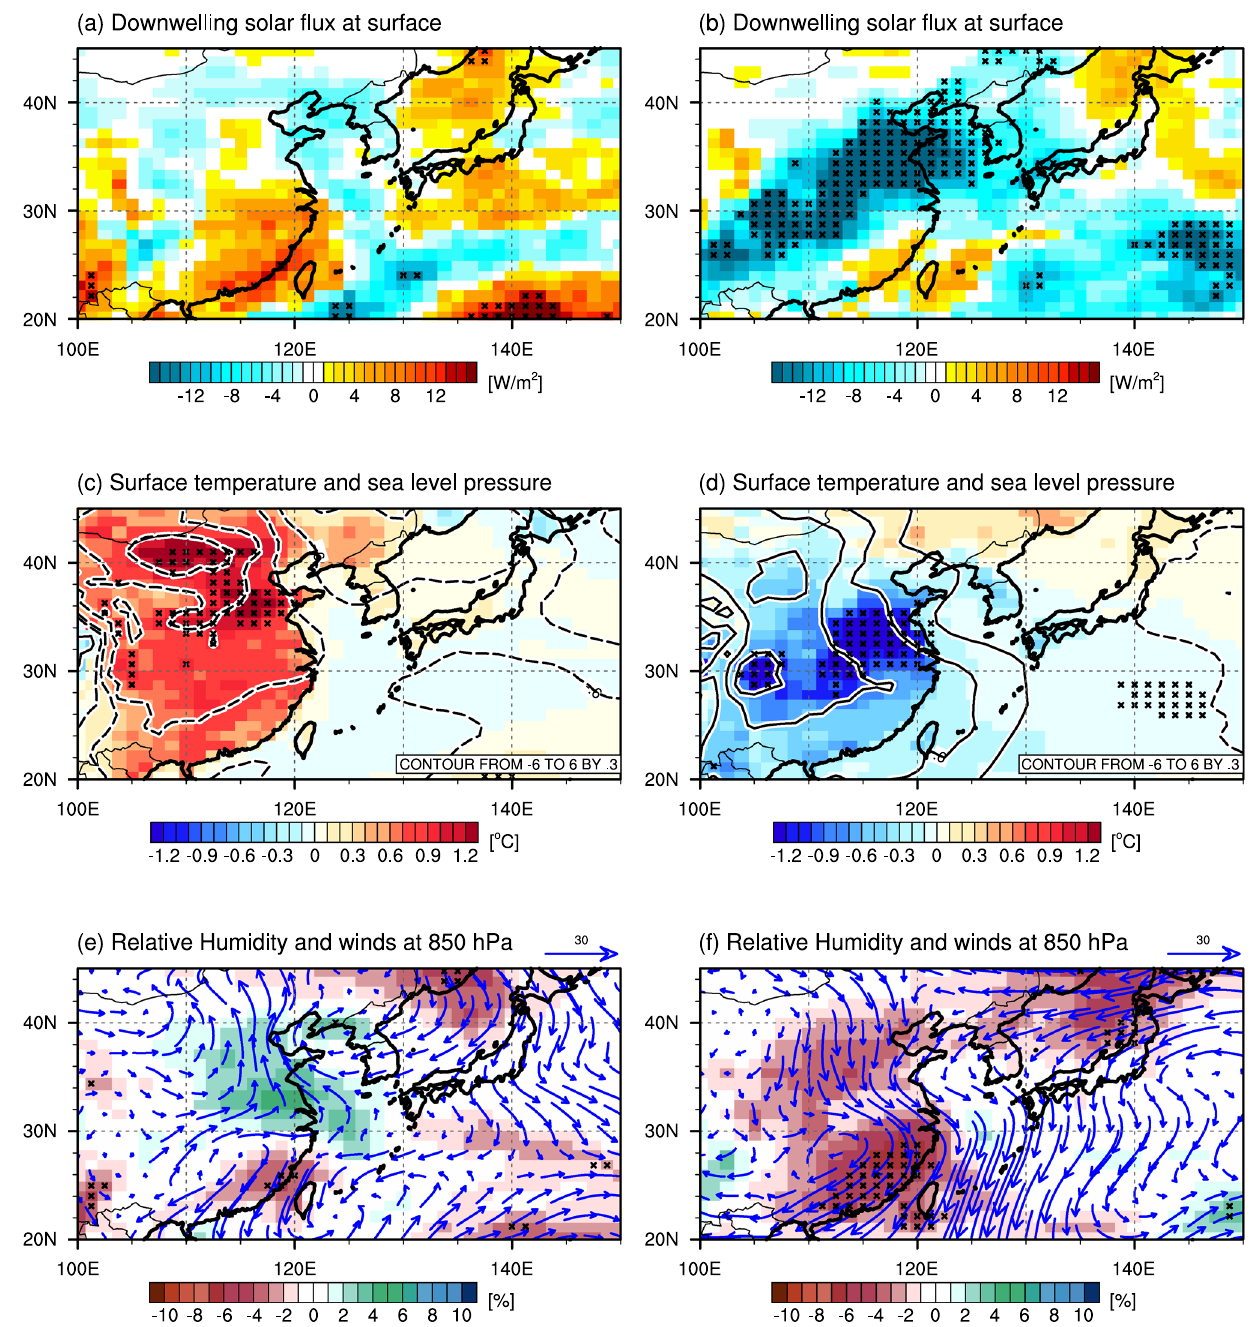
Figure 3. Difference fields in February between W_AER and CTL (left panels) and between S_AER and CTL (right panels). ( a , b ) Downwelling solar flux at surface, ( c , d ) surface temperature (shading) and sea level pressure (contour), and ( e , f ) relative humidity (shading) and wind (vector) at 850 hPa. Black crosses represent grid points where the composite mean difference is significant above the 90% confidence level. The figure was generated using NCAR Command Language Version 6.5.0 (http:// dx. doi. org/ 10. 5065/ D6WD3